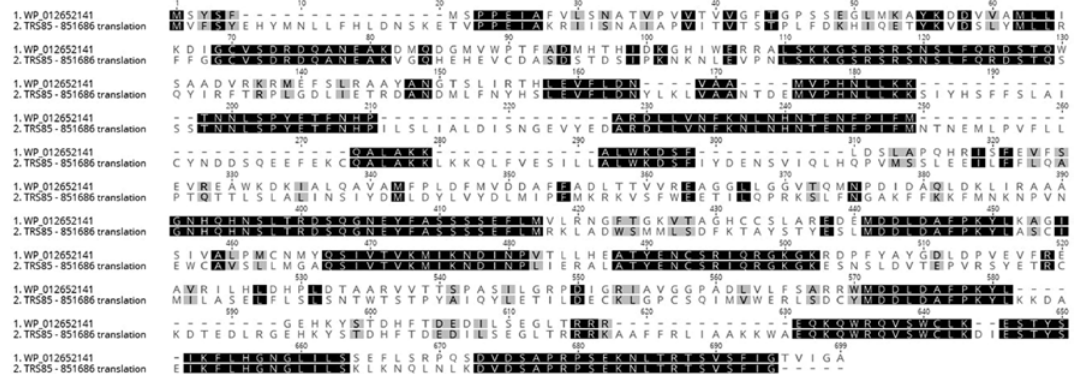
Figure 8: Alignment matrix of target sequence (WP_012652141) and query sequence